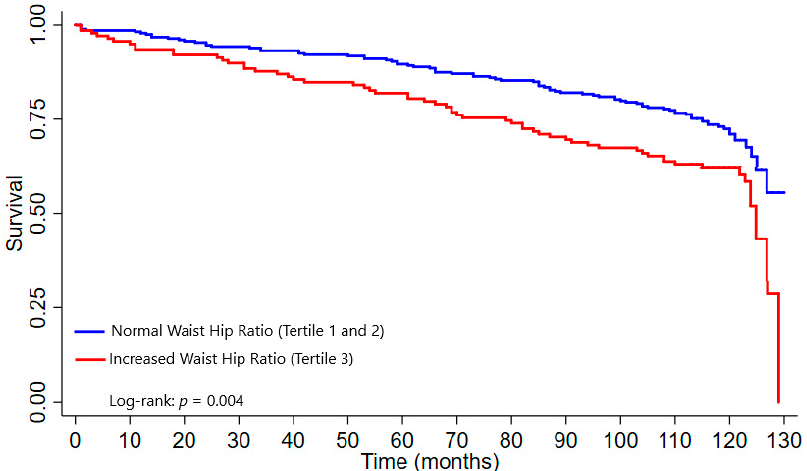
Figure 1. Survival curve according to Waist hip ratio (WHR).